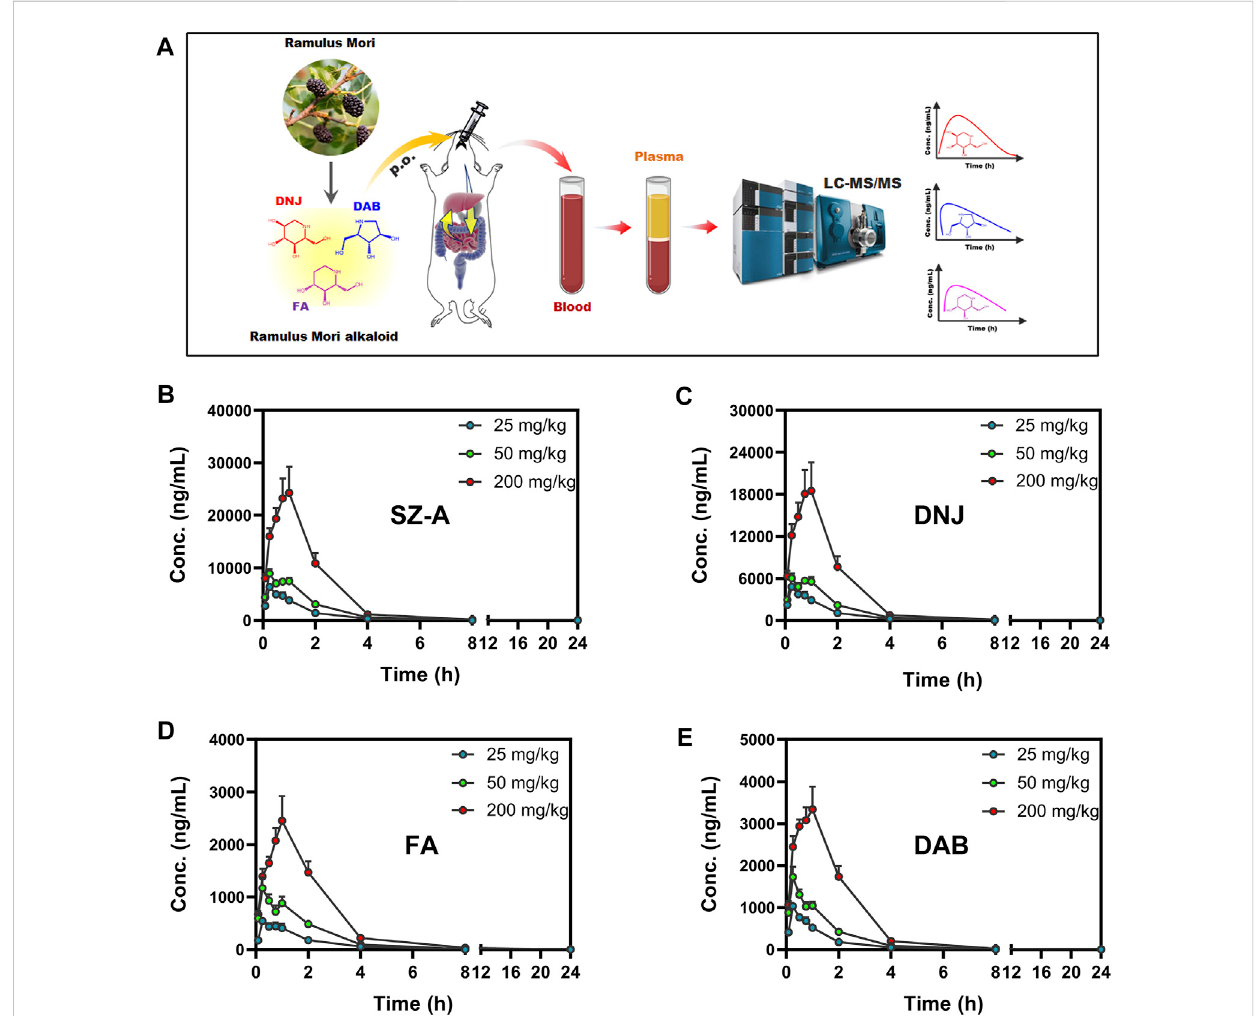
FIGURE 2 Experimental scheme of plasma concentration determination after oral administration of SZ-A (25, 50, and 200 mg/kg) in rats (A) . Mean plasma concentration-time pro fi les of SZ-A (B) , DNJ (C) , FA (D) , and DAB (E) in rats following oral administration of SZ-A. Each value represents the mean ±standard error of mean (SEM) ( n =